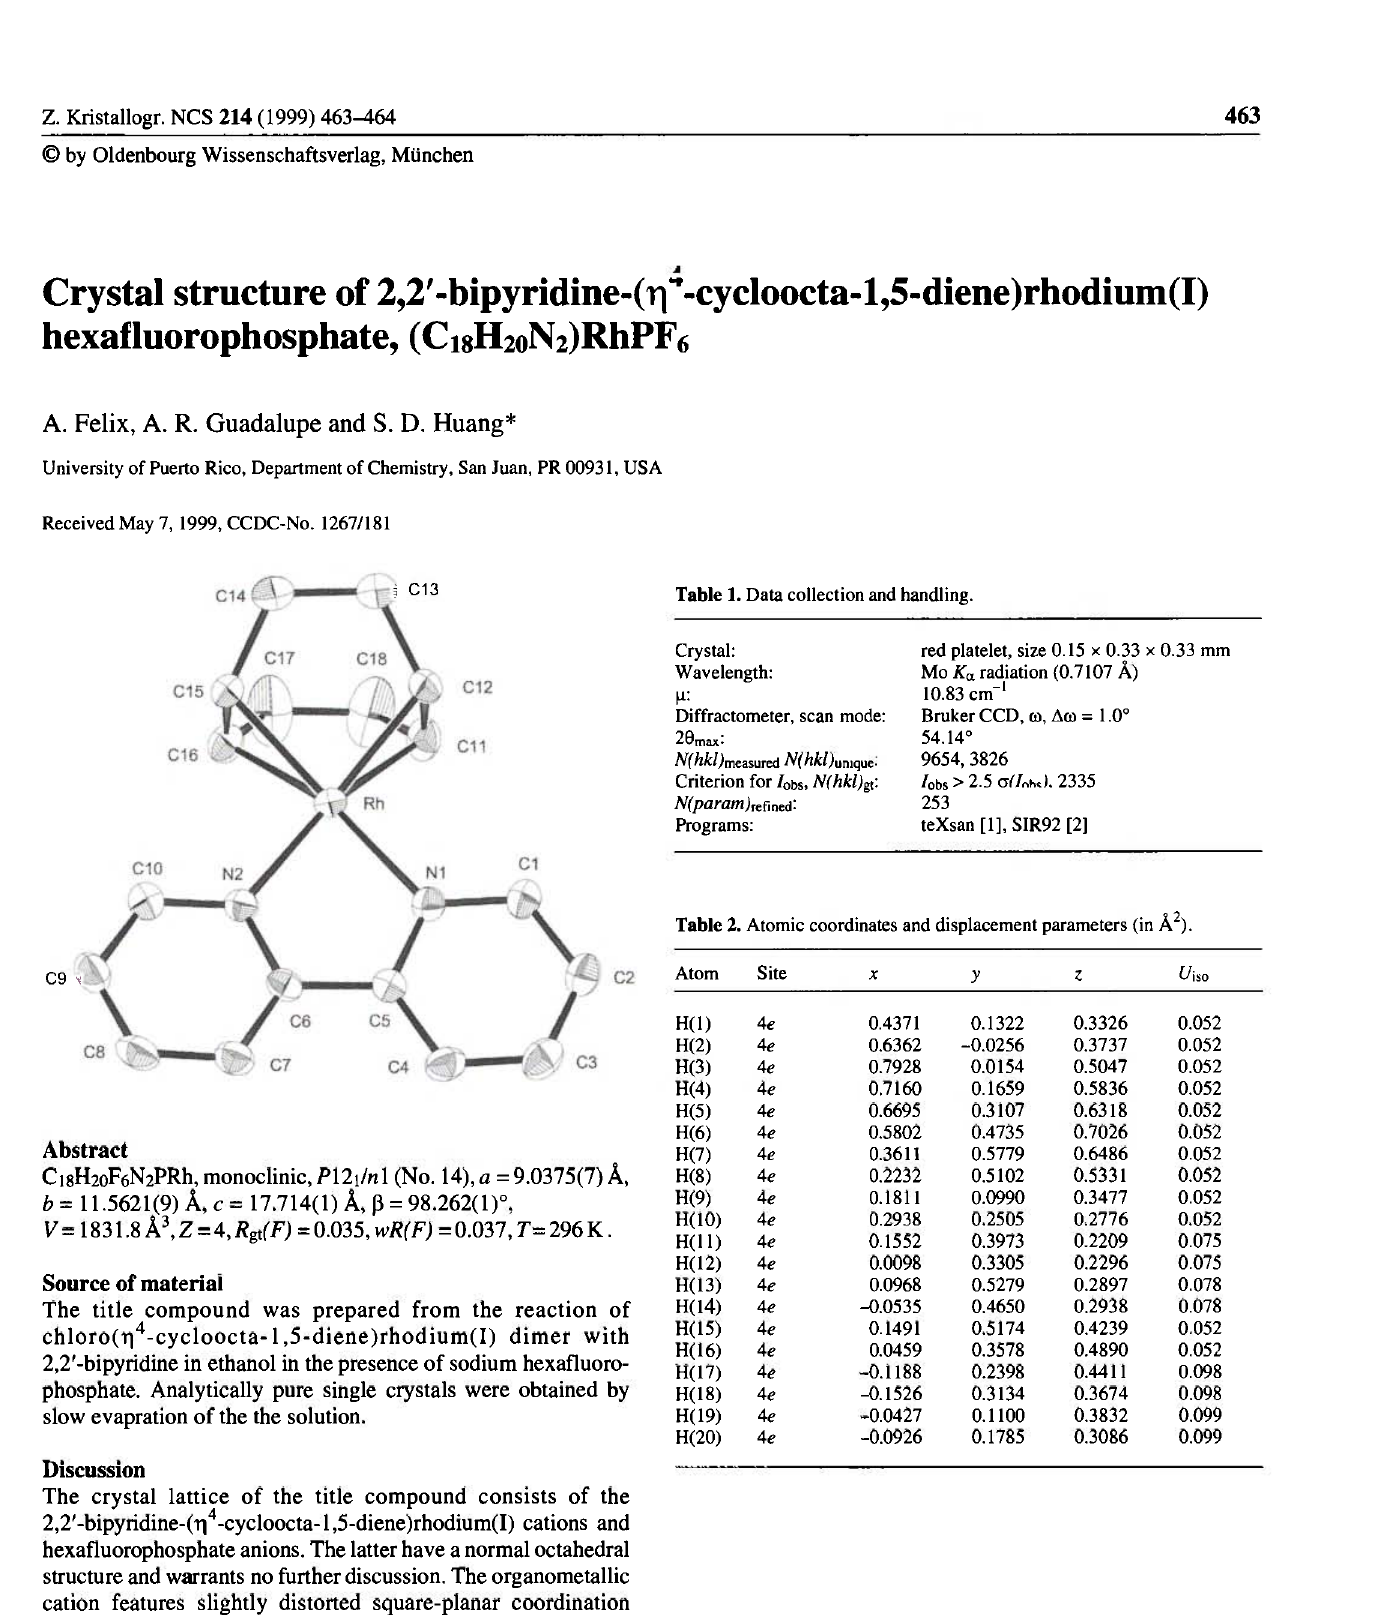
Table 2. Atomic coordinates and displacement parameters (in Ä 2